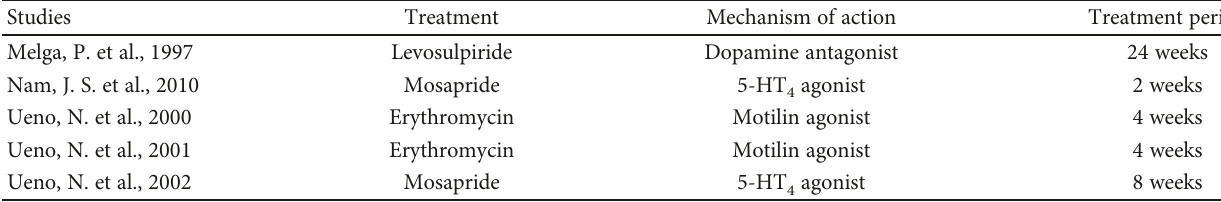
Table 1: Main characteristics.